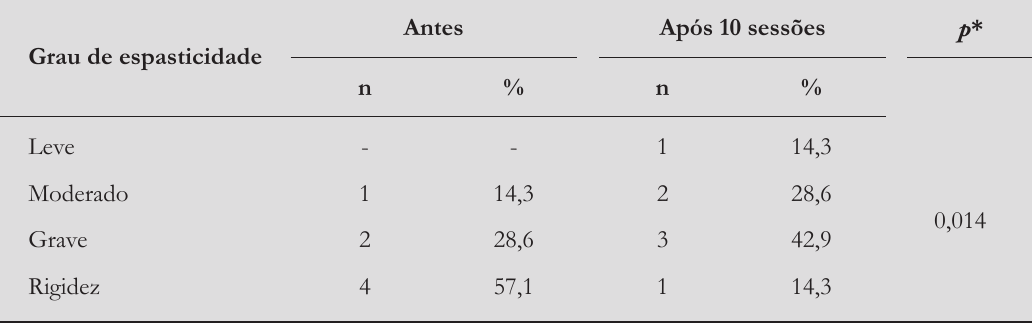
Tabela 3 - Análise do grau de espasticidade das articulações do punho, metacarpofalangeas e interfalangeas no primeiro e décimo dia de tratamento